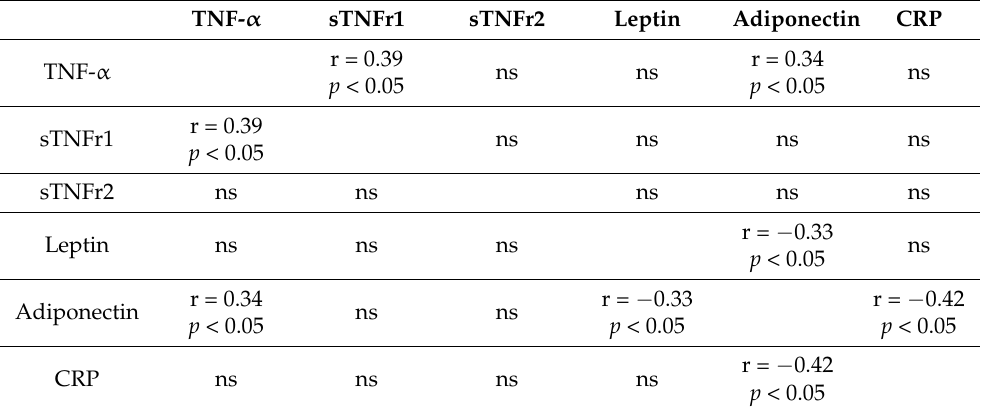
Table 5. Correlations between BMI, TNF activity and adipokines in obese patients.